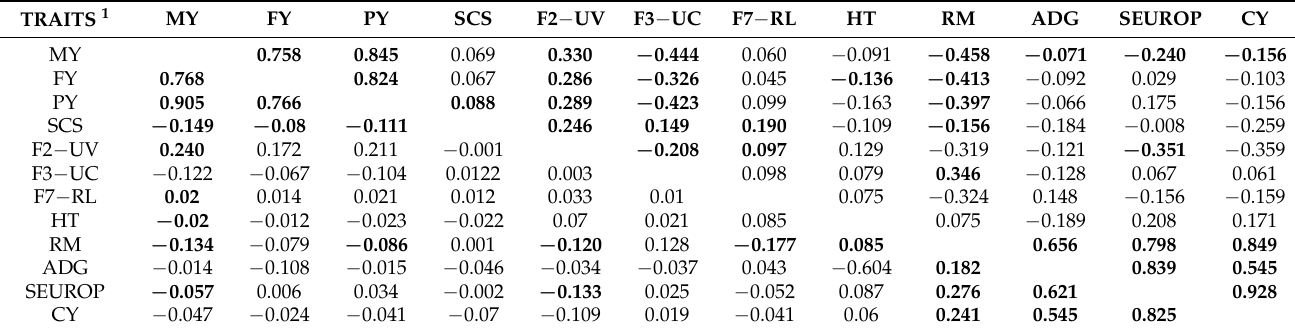
1 MY = Milk yield; FY = Fat yield; PY = Protein yield; SCS = Somatic cell score; F2 − UV = Udder volume factor; F3 − UC = Udder conformation factor; RL − F7 = Rear legs factor; HT = Head typicality; RM = Rear muscularity; ADG = Average daily gain; SEUROP = in vivo SEUROP score; CY = in vivo carcass